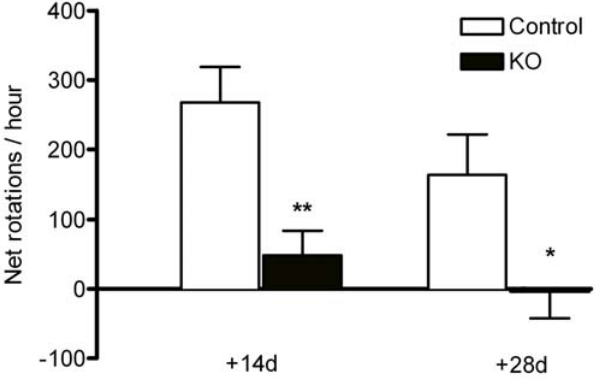
Figure 9. The morphological preservation of the Pten deficient nigrostriatal system after 6OHDA treatment correlates with functional recovery after the lesion. To determine the functionality of the nigrostriatal system after the lesion, we examined methamphet- amine-induced rotations. Methamphetamine treatment increases the extracellular availability of endogenous DA in the striatum, and it causes animals with a partial DA depletion to rotate against the lesion side (ipsilateral), due to the imbalance in DA release between the striatae. Strong ipsilateral rotational behavior was observed in control animals (n=8) after treatment with ( + ) methamphetamine HCl (2.5 mg/kg) at 14 and 28 days after the lesion. Ipsilateral rotational behavior was significantly reduced in Pten KO animals (n=10). All data are mean 6 SEM. *p , 0.05, Student’s t-test.